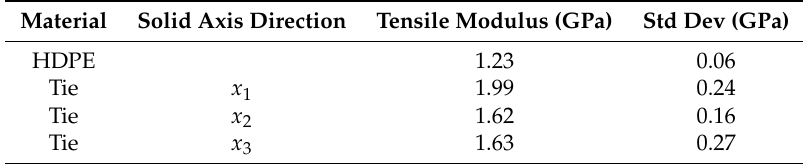
Table 1. Experimental tensile testing results for HDPE and tie samples.